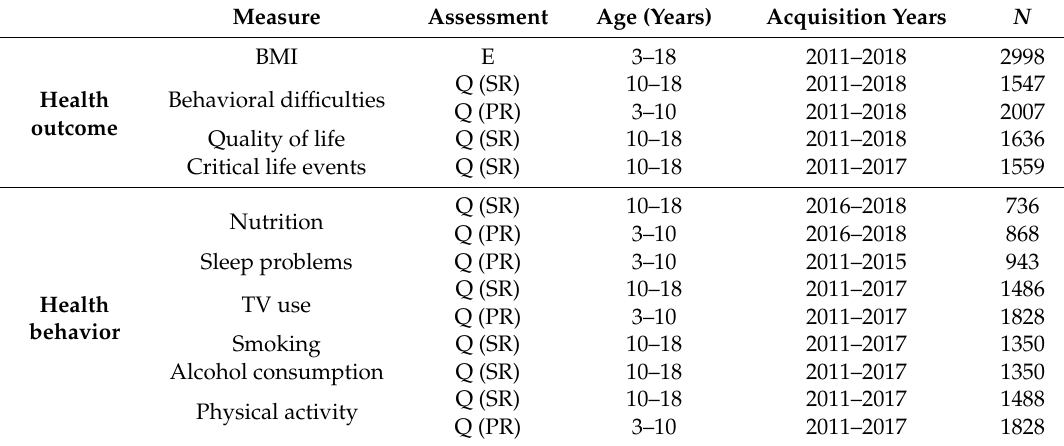
Table 1. Description of study samples and